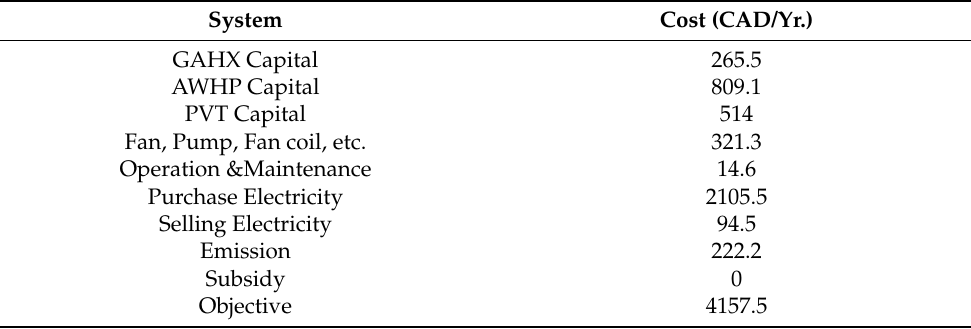
Table 5. Breakdown of the Annual Optimum Cost for a Trigeneration System. System Cost (CAD/Yr.)